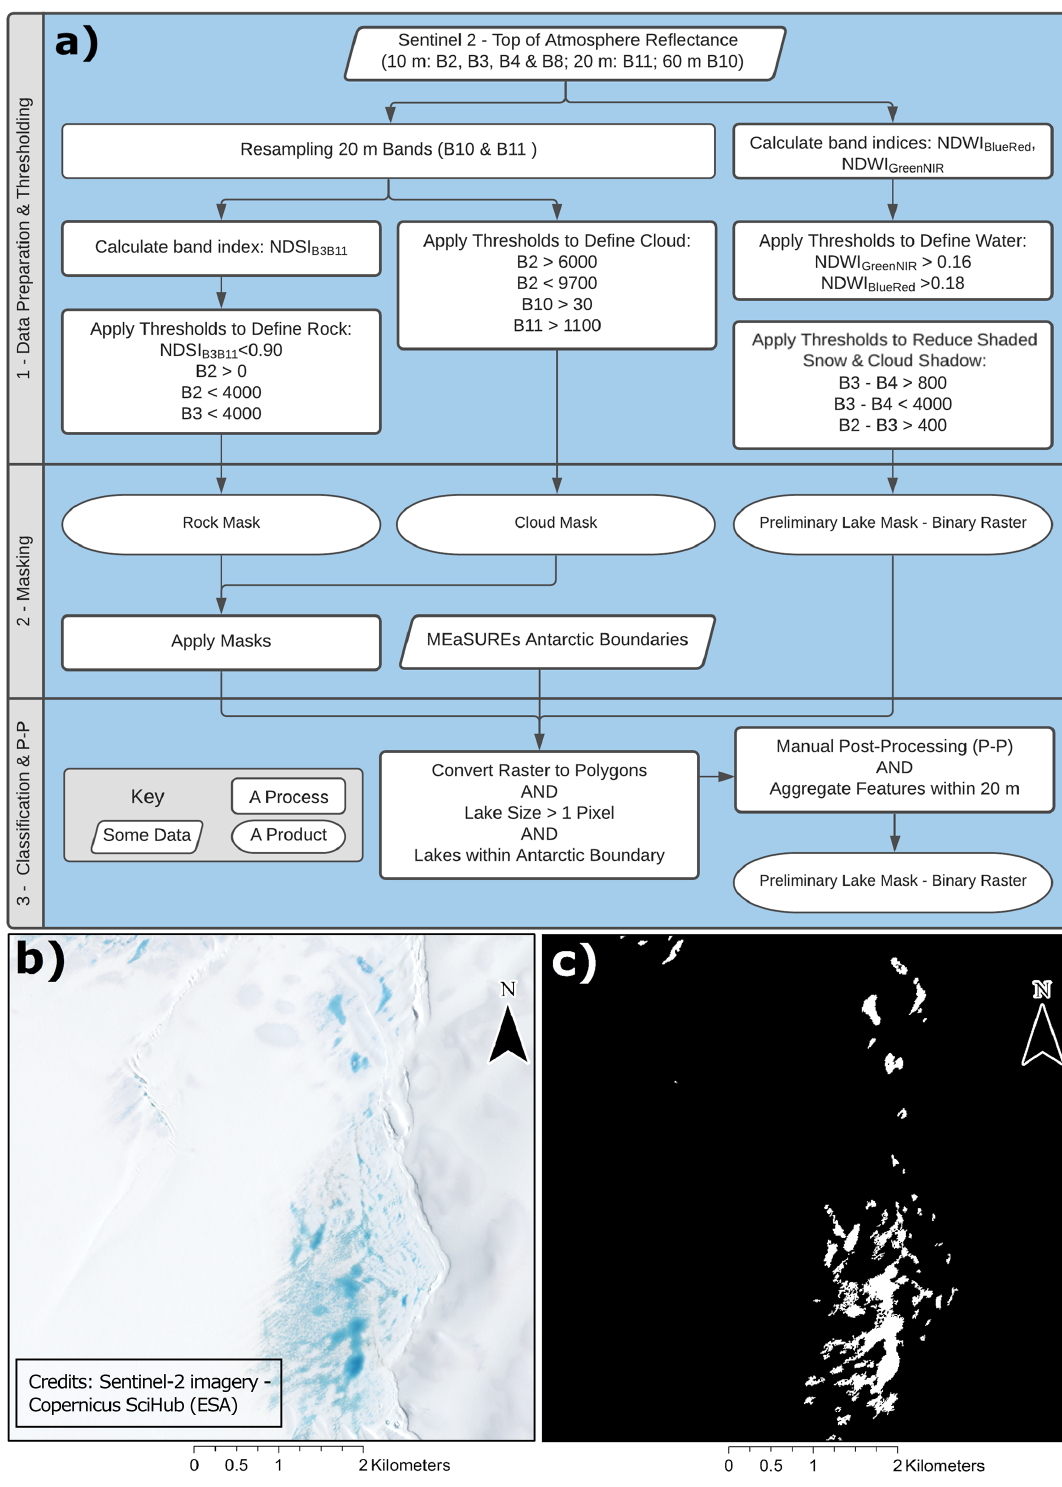
Figure 2. S2 processing chain (a) . The input files are the S2 Multi-Spectral Instrument (MSI) products (RGB composite of tile T13CET_20170106 from 6 January 2017 on Pine Island Glacier b ), and the output is the supraglacial lake and channel binary (surface water – not water) classification (c) . Imagery was accessed from European Space Agency’s (ESA) Copernicus Scihub, http://scihub.copernicus.eu (last access: 3 December